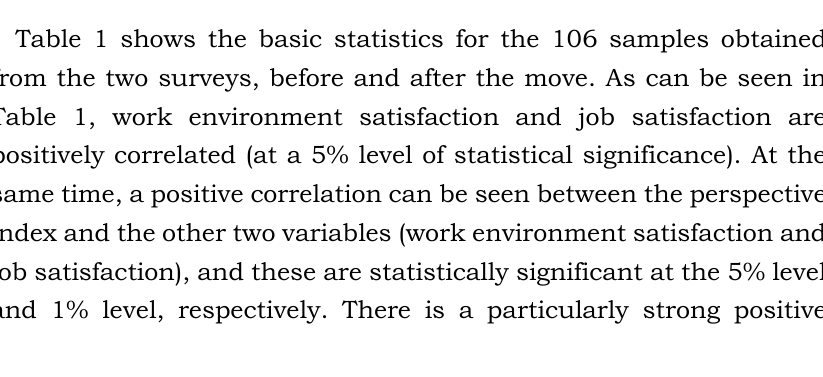
Table 1. Mean, standard deviation, and correlation of the three